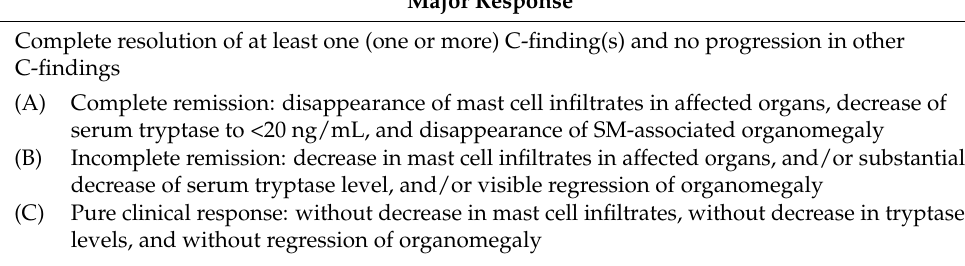
Table 1. Valent Response Criteria in aggressive systemic mastocytosis (ASM) and mast cell leukemia